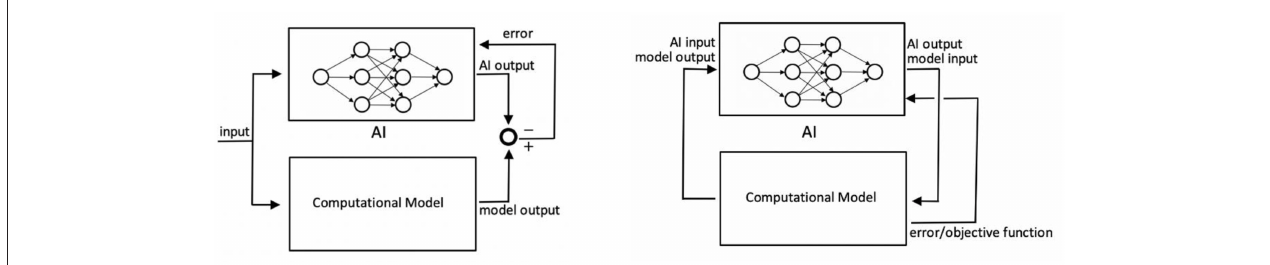
FIGURE 1 | Left: training an AI as a cheap surrogate model of a classical computational model in order to make predictions about input-output relations in a physical system or process. The difference between AI output and model output is an error that can be used for AI training (e.g., using backpropagation algorithms). Right: AI is used to take action in or control a physical environment or parts of it. The error controlling AI training has to be computed in some way from the AI-governed evolution of the computational model (e.g., using some objective functions assessing the current or final state of the computational